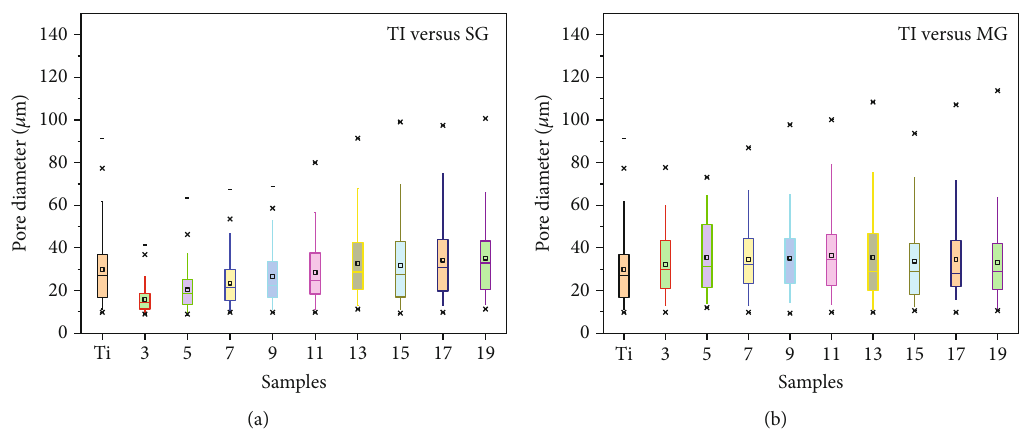
Figure 6: Pore diameter distributions of the simulation realizations: (a) single-grid scheme; (b) multiple-grid scheme.